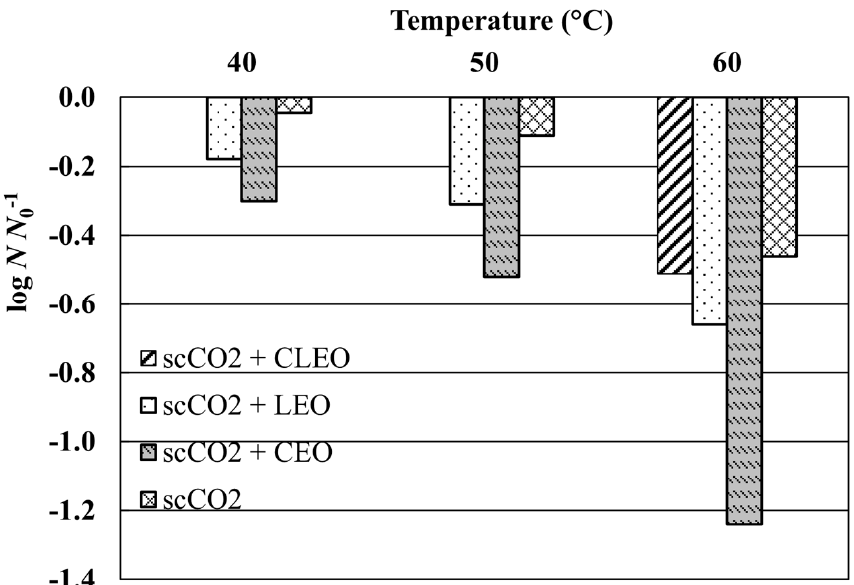
Figure 3. Inactivation of Clostridium spores in honey using scCO 2 alone and scCO 2 combined with lemon essential oil (LEO), clove essential oil (CLEO), and cinnamon essential oil (CEO). Conditions: P = 10 MPa; Q = 1 g min − 1 ; stirring rate = 60 rpm; operation time = 60 min.